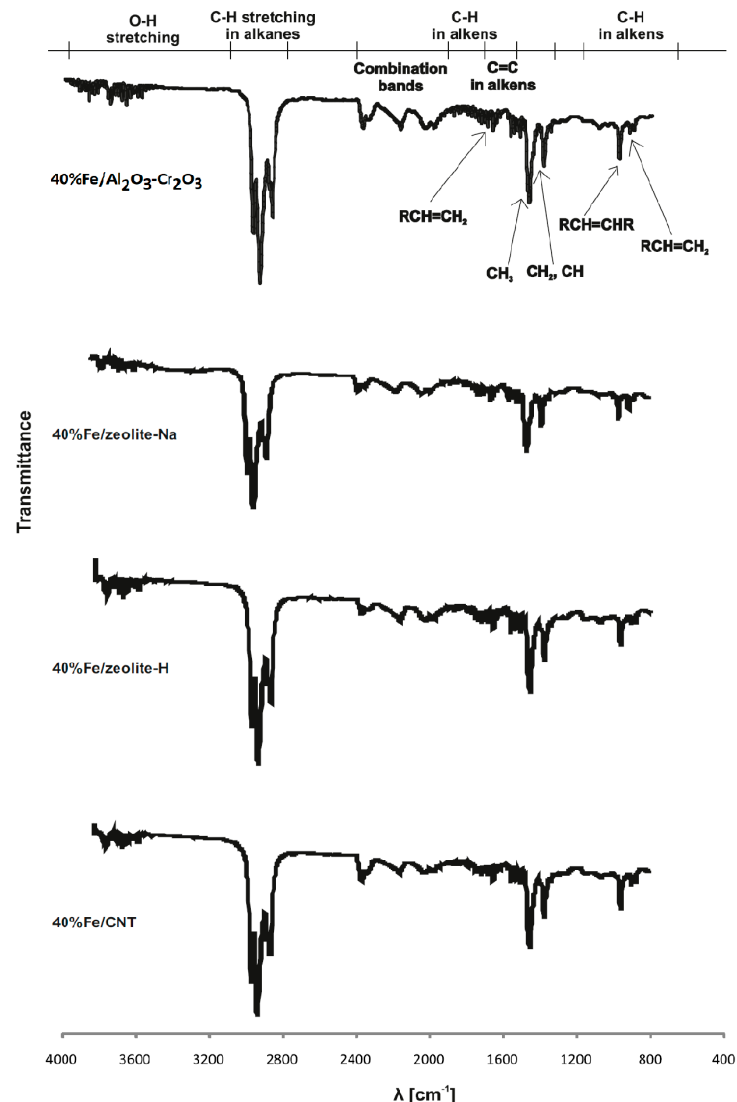
Figure 2. Fourier transform infrared spectrometry (FTIR) spectra’s of the product formed in the hydrogenation of the CO process at 280 °C under elevated pressure (3 MPa) from a mixture of H 2 and CO (50% CO and 50% H 2 ) using Fe catalysts supported on various carriers (binary oxides, zeolite-Na, zeolite β -H and MWCNTs) calcined in an air atmosphere at 500 °C for 4 h and activated in a reaction mixture.